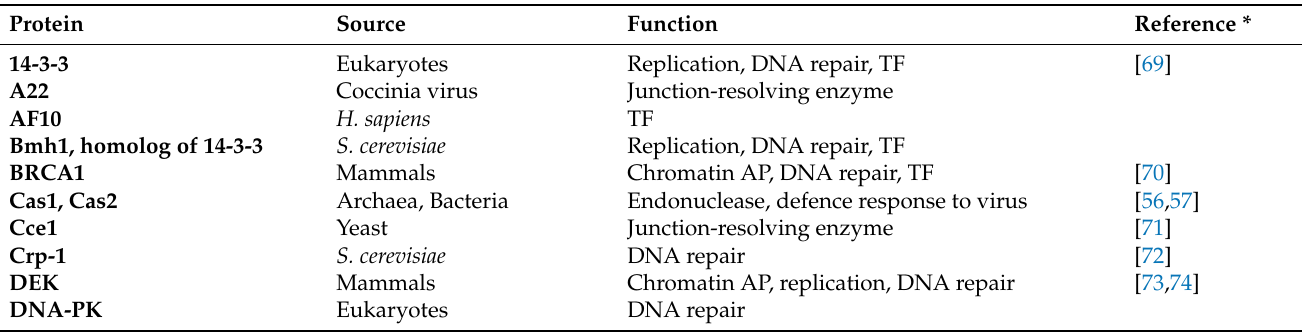
Table 1. Proteins involved in interactions with cruciform structures. TF = transcription